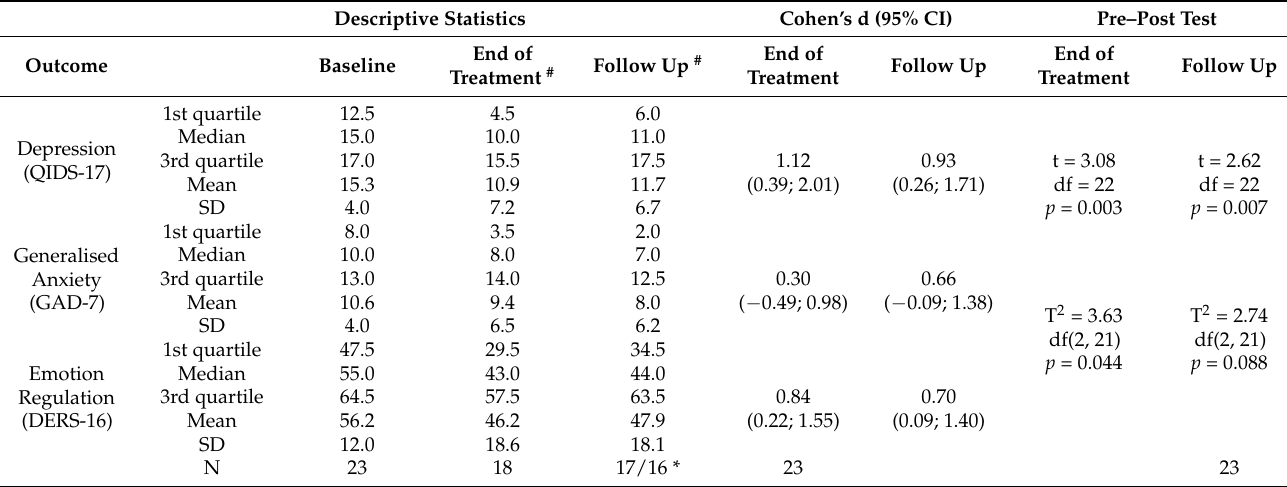
Table 3. Distribution of QIDS-17, GAD-7 and DERS-16 ratings at baseline, end of treatment, and follow up (missing values replaced by last available